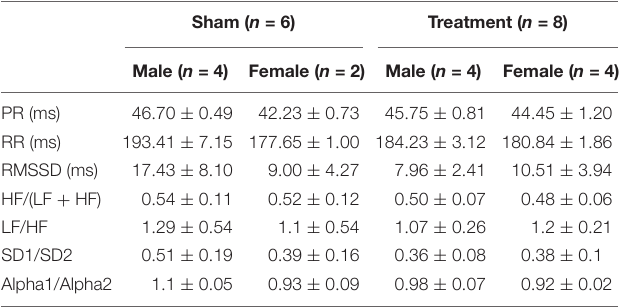
TABLE 1 | Baseline ECG features estimated from the pre-VNS timepoint in different groups (mean ± SEM). Sham ( n =